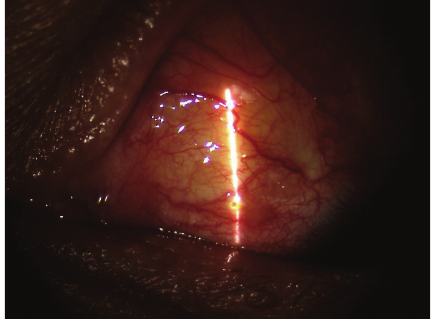
Figure 1: The internal bore of the stent is clearly visible into the anterior chamber.